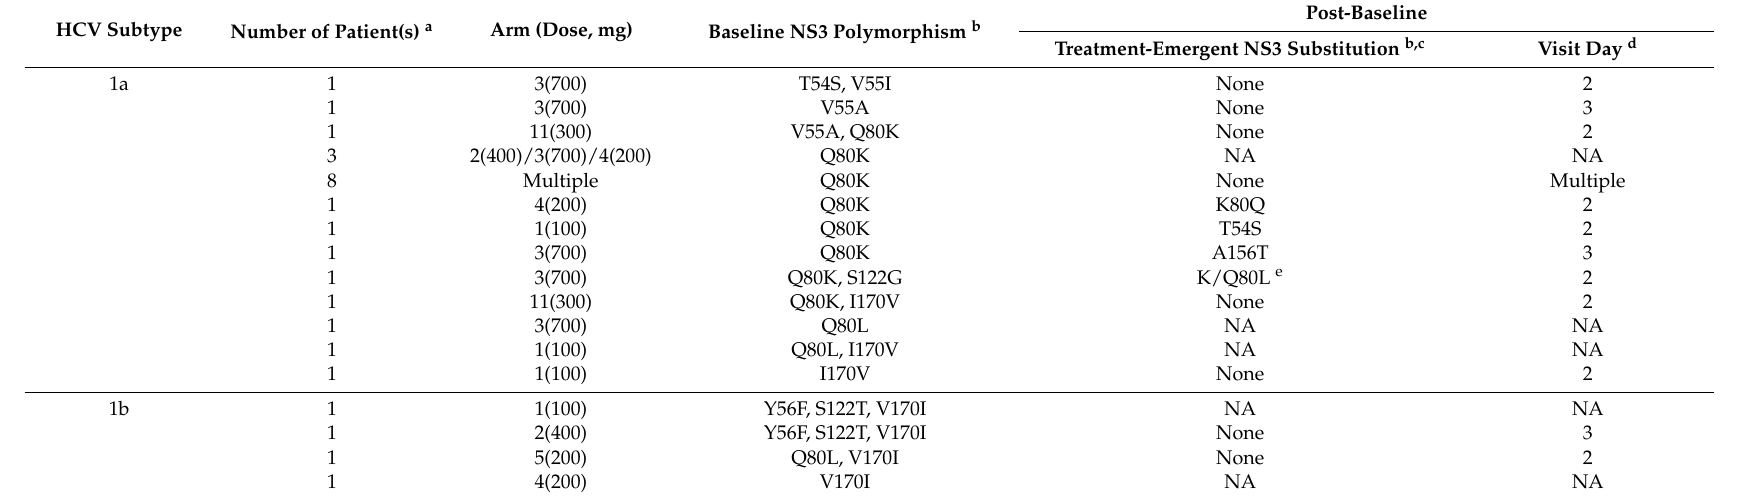
a Patients are grouped by baseline polymorphism profile. Table does not list the 21 patients without baseline polymorphisms; 16 of these 21 patients had post-baseline sequence data available, and none of the 16 patients had treatment-emergent substitutions. b For substitutions in a mixture with wild-type sequences, only the substitutions are shown. Substitutions at NS3 amino acid positions 36, 43 (genotype 1a only), 54, 55, 56, 80, 122, 155, 156, 168, and 170 were included in the analysis. c Substitutions detected in the latest sample with an HCV RNA level ≥ 1000 IU/mL during 3-day monotherapy. d Post-baseline samples collected prior to dosing of drug on the days of visit; e.g., a “visit day 3” sample represents a sample collected after 2 days of monotherapy. e Substitution (L) emerged in this patient with baseline sample containing a mixture of wild-type (Q) and a polymorphism (K). NA: Not available due to low